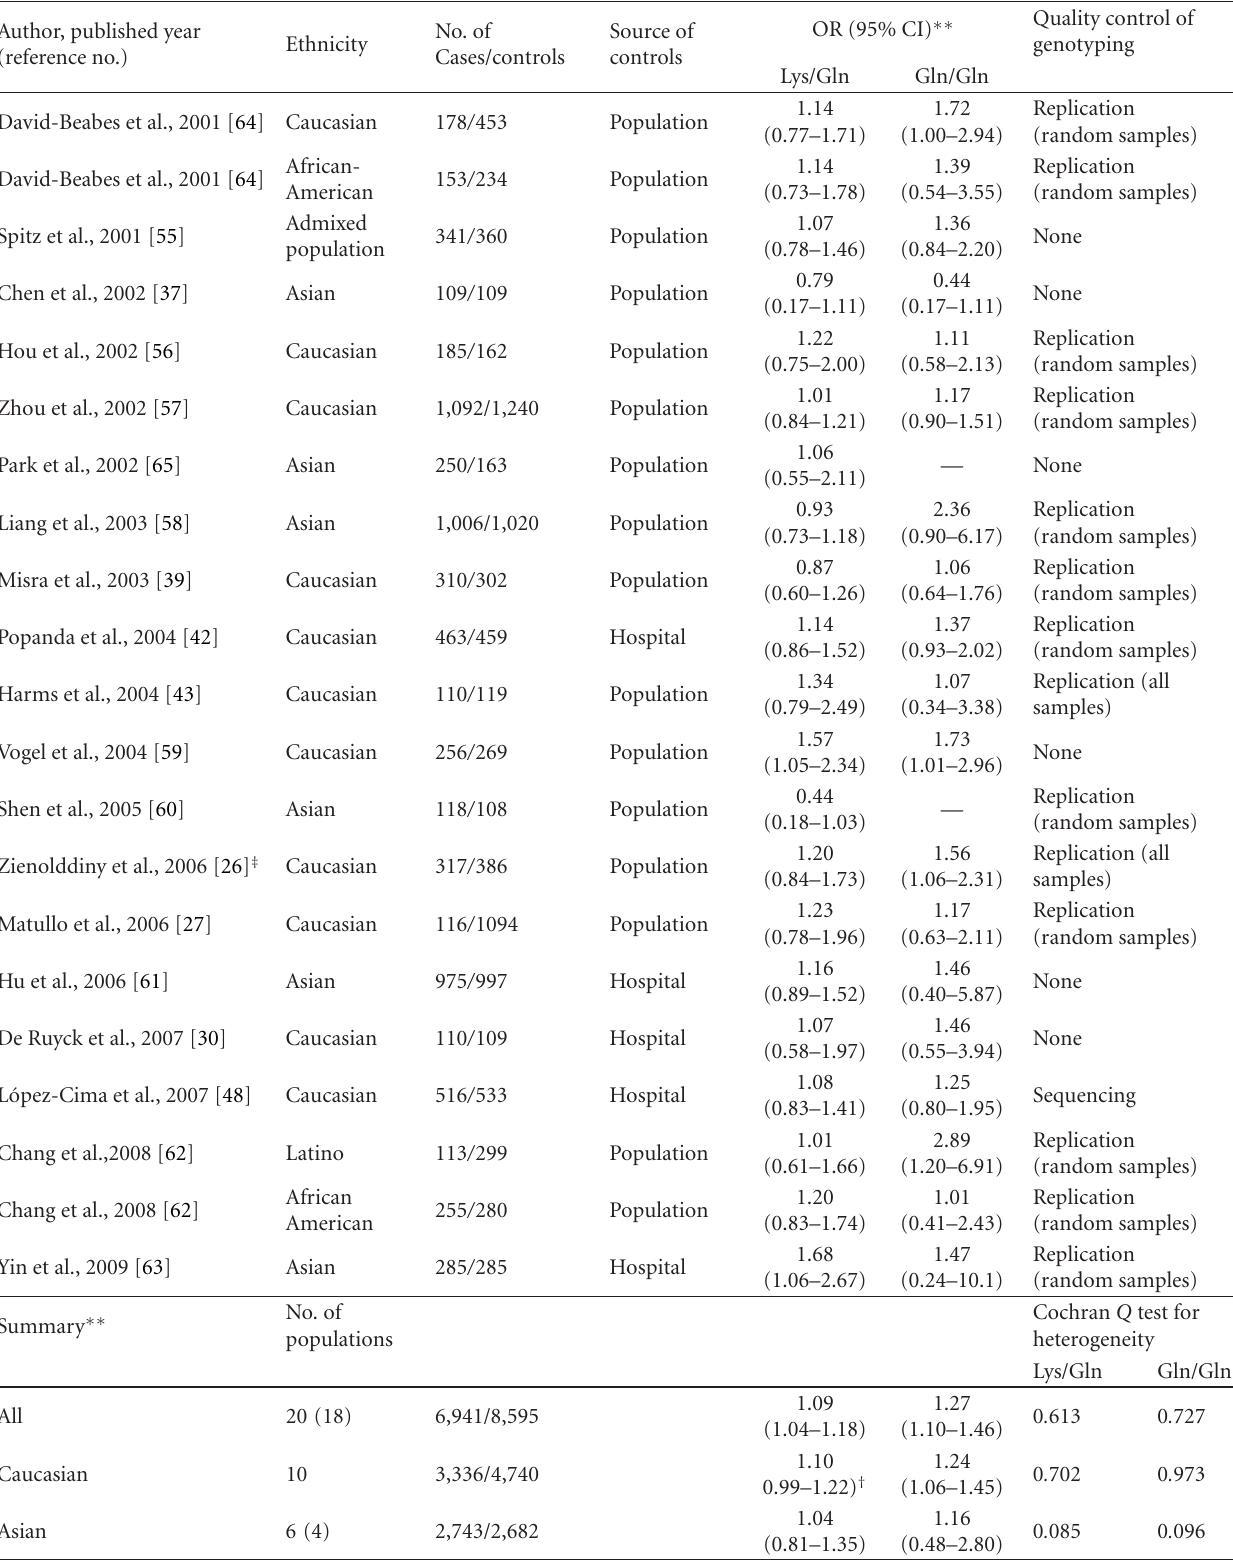
Table 8: Genetic polymorphisms in the NER pathway and lung cancer risk: ERCC2 Lys751Gln